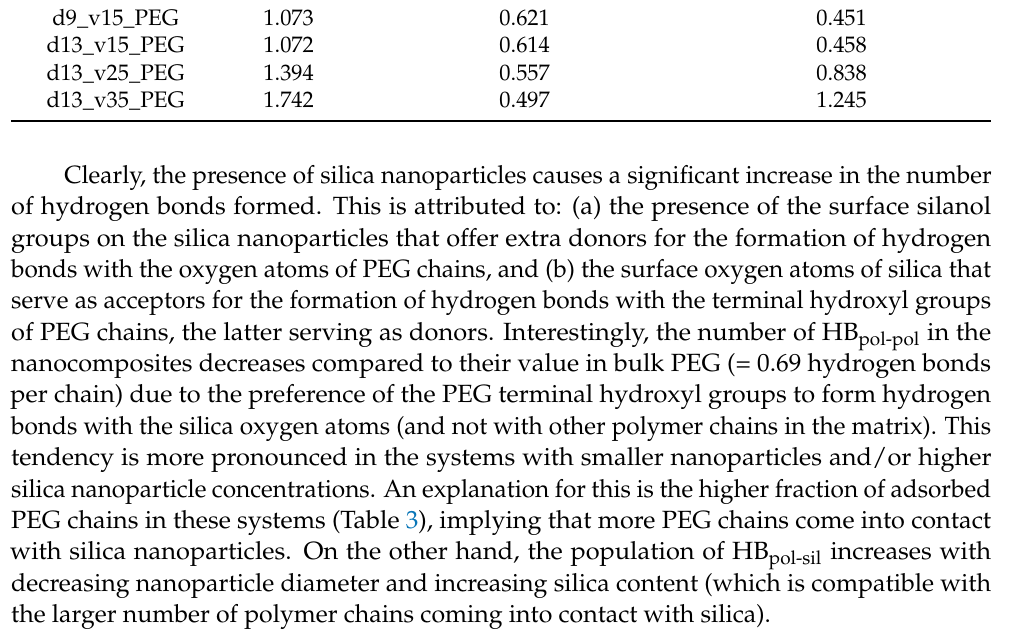
(cid:10) (cid:11) R 2 ee of PEG chains ( T = 413 K and p = 1 atm). As also explained in